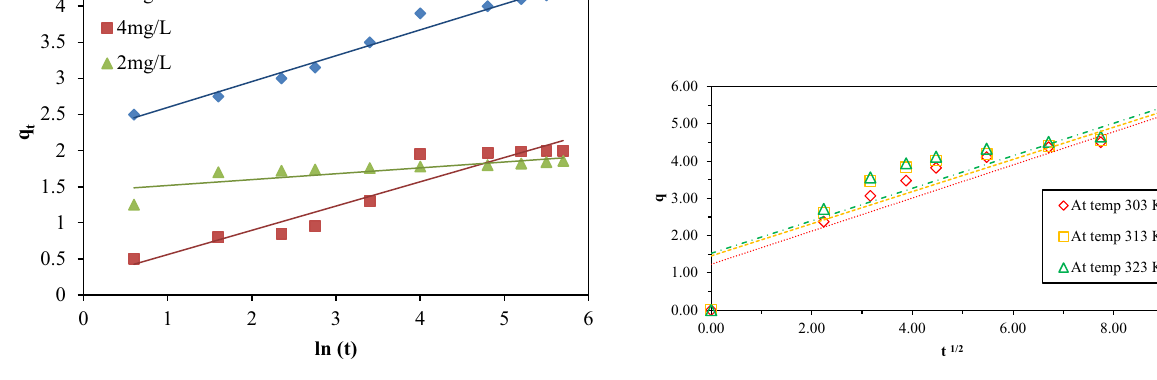
Fig. 15 Plot for q versus t ½ for MR sorption onto SCTJF at tempera- ture 303 K, 313 K and 323